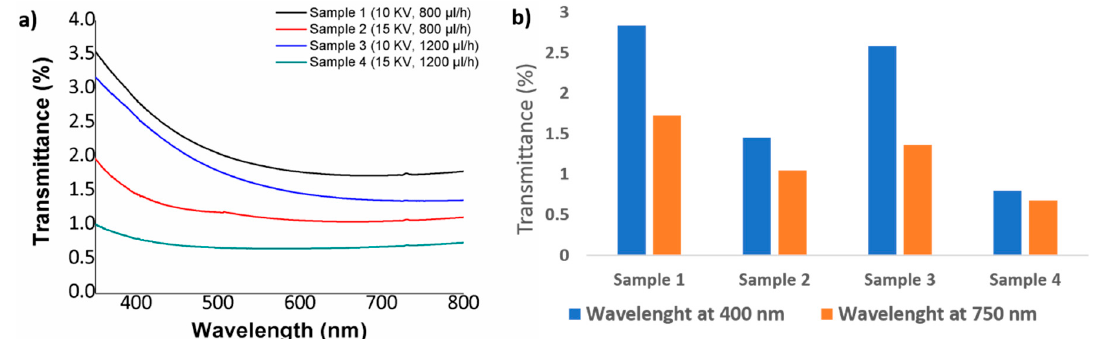
Figure 6. ( a ) UV–vis spectra of the resultant PVC fibers for a fixed polymeric concentration of 15 wt % as a function of the applied voltage (10 or 15 KV) and flow rate (800 or 1200 µL); ( b ) Transmittance change at a specific wavelength of the visible region at 400 nm and 700 nm, respectively.